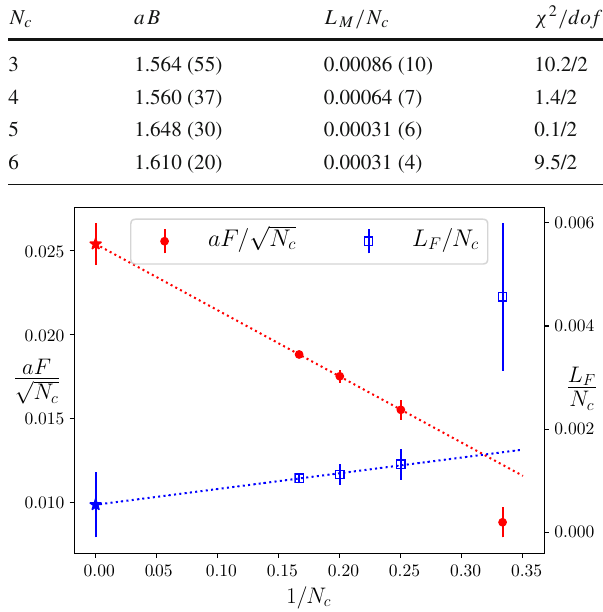
√ N c (red)and L F (blue).Thedottedlines Fig. 2 N c dependenceof F / are the best fits to Eqs. (5) and (7) excluding the data points at N c =